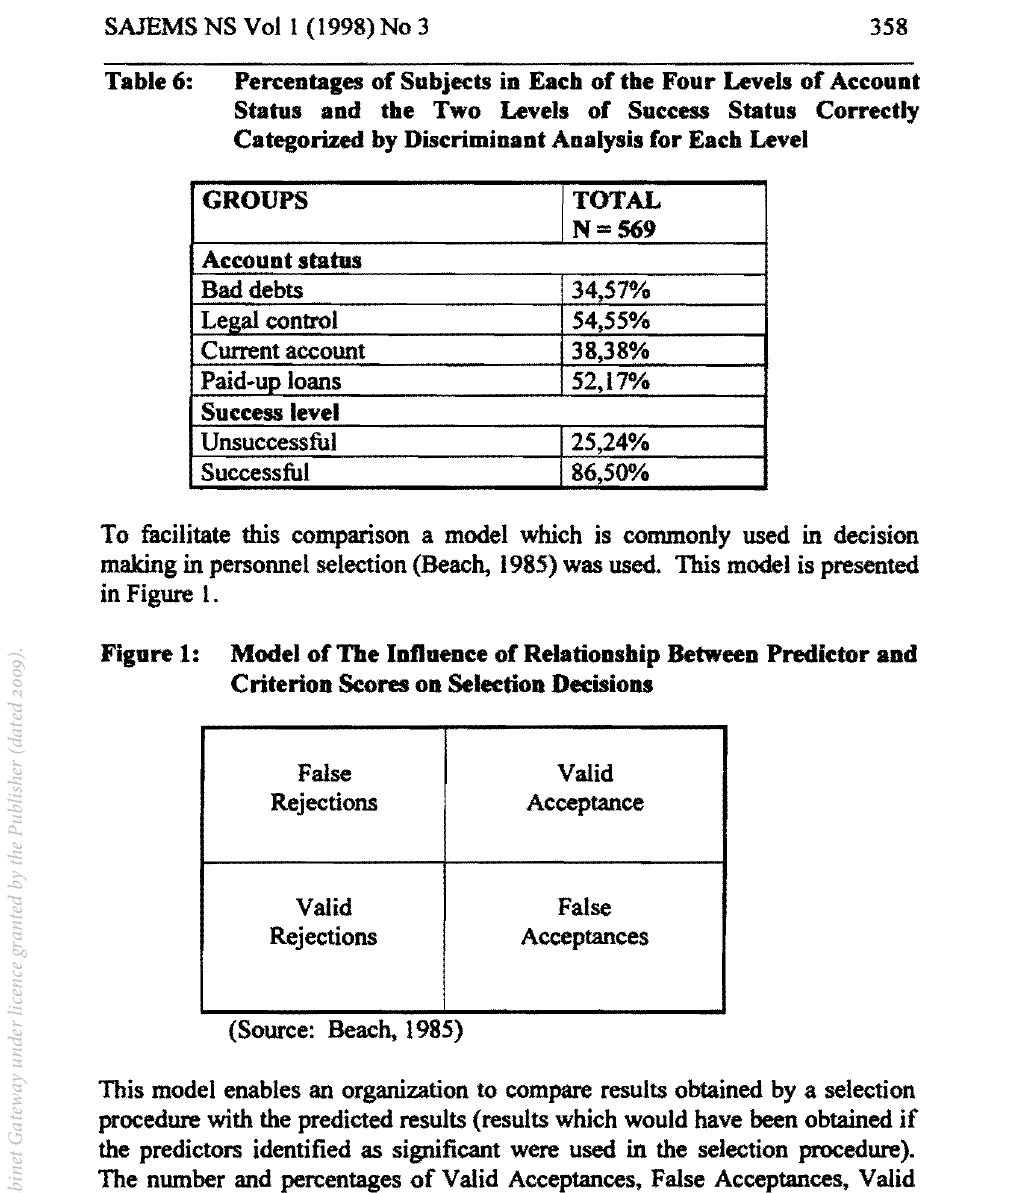
Model of The Inflnence of Relationship Between Predictor and Criterion Scores on Selection